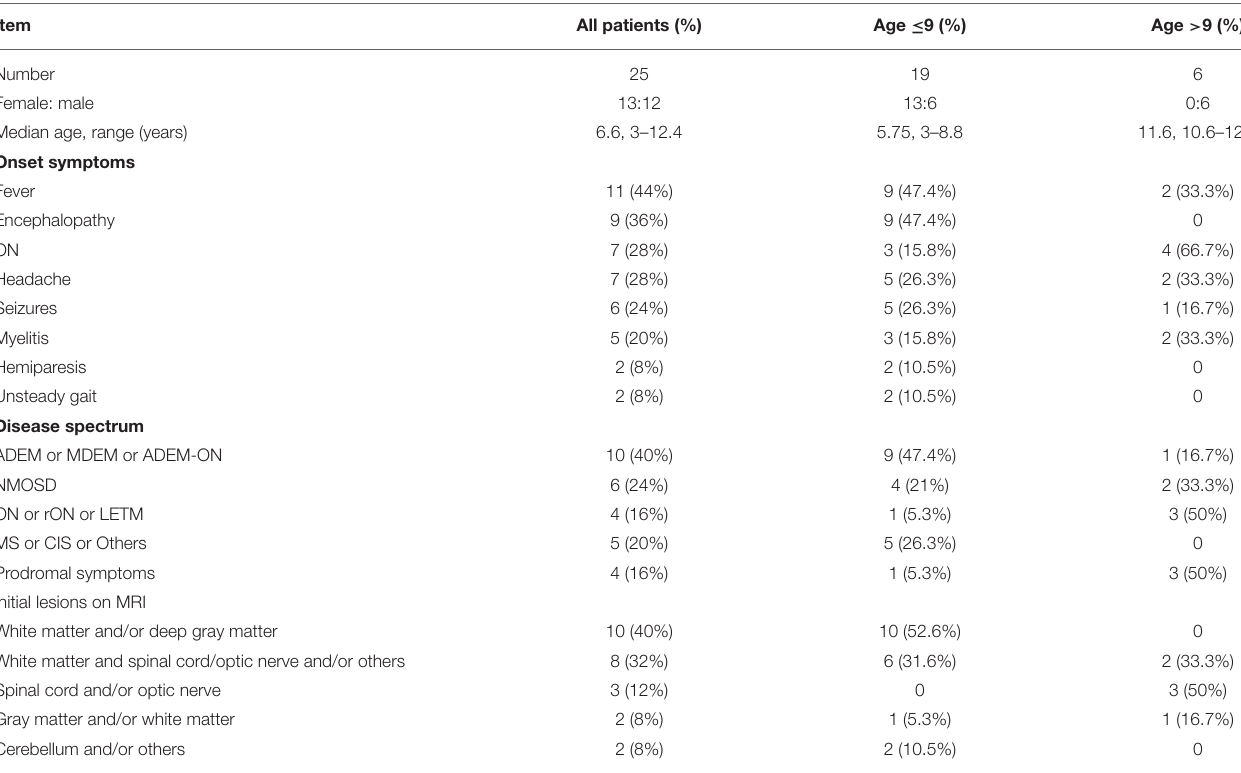
TABLE 2 | Demographics, clinical characteristics and MRI findings.